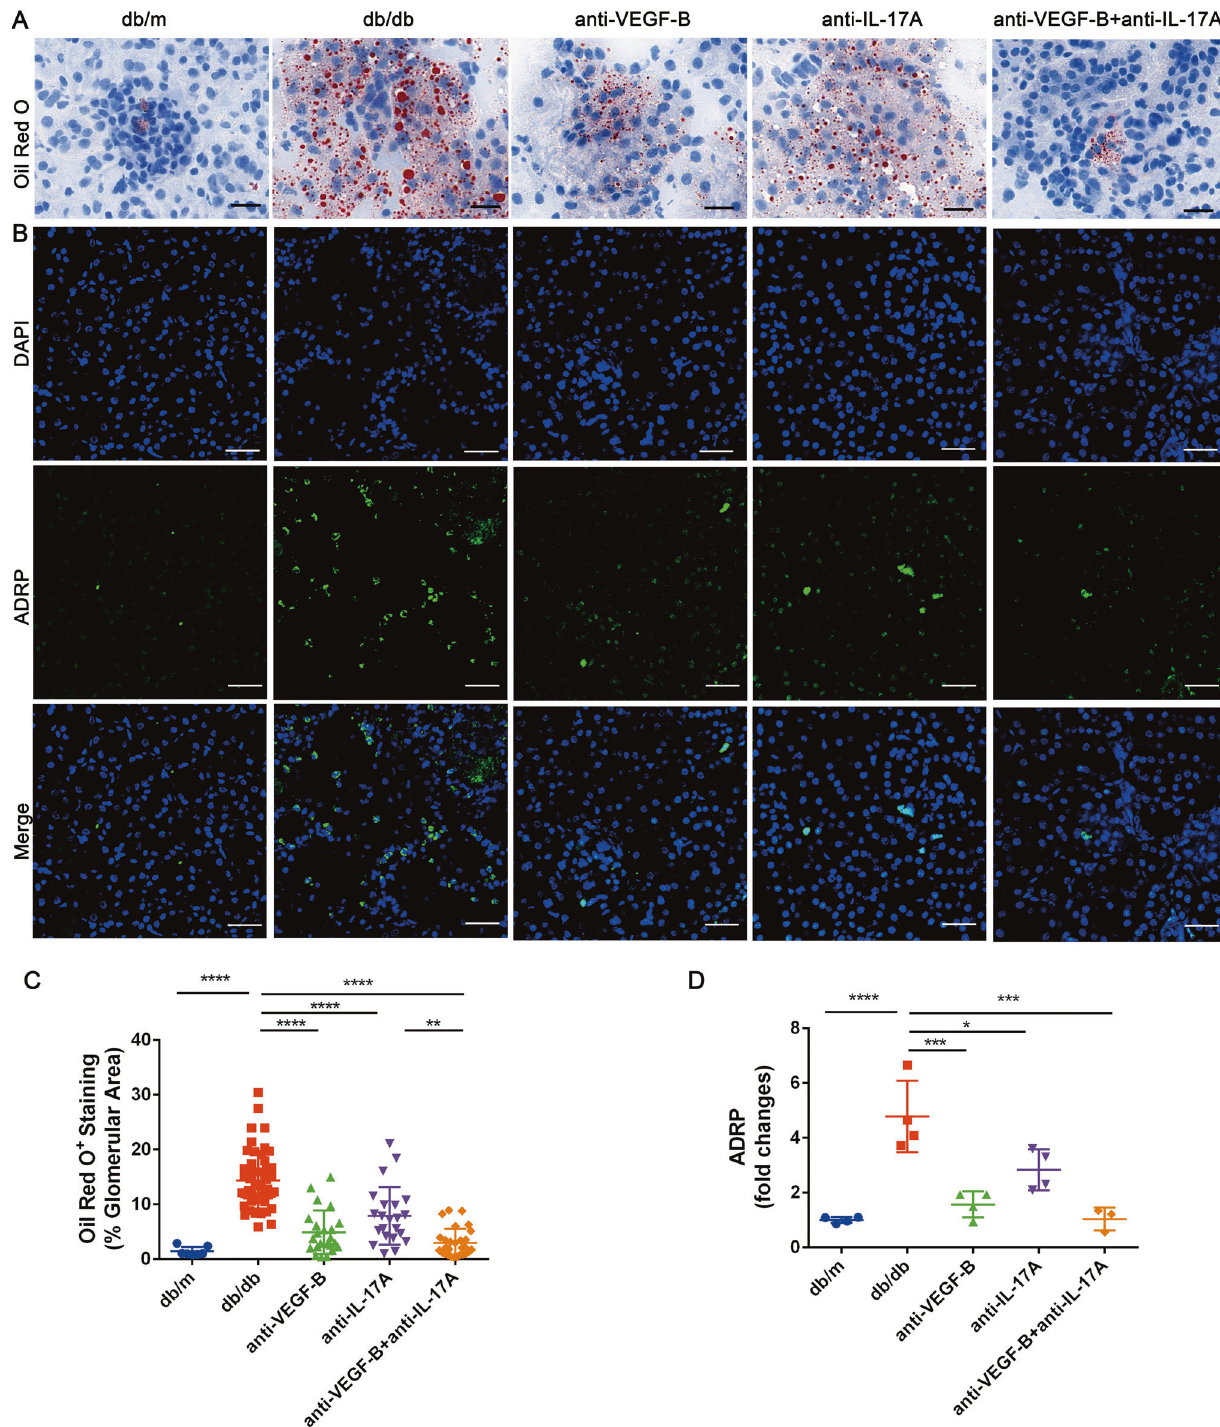
Fig. 4 Treatment of the neutralizing VEGF-B and IL-17A antibodies simultaneously reduced the renal ectopic lipid accumulation. A Oil Red O staining was used to assess the neutral lipids (NLs) in kidney sections (scale bar: 10 μ m). B ADRP expression was used to assess the lipid droplets (LDs) by immuno fl uorescence analysis (scale bar: 10 μ m). C Quantitative analysis of Oil Red O staining of kidney sections, n = 4 mice in each group, per section/per mice, 2 – 5 glomerulus or tubulointerstitial/per section. D Quantitative analysis of the fl uorescent intensity of ADRP, n = 3 – 4 mice in each group, per section/per mice, per positive area/per section. The data were presented as means ± SD, **** P < 0.0001, *** P < 0.0001, ** P < 0.01, * P < 0.05 . The statistical signi fi cance was analyzed by one-way ANOVA with Tukey ’ s multiple-comparisons